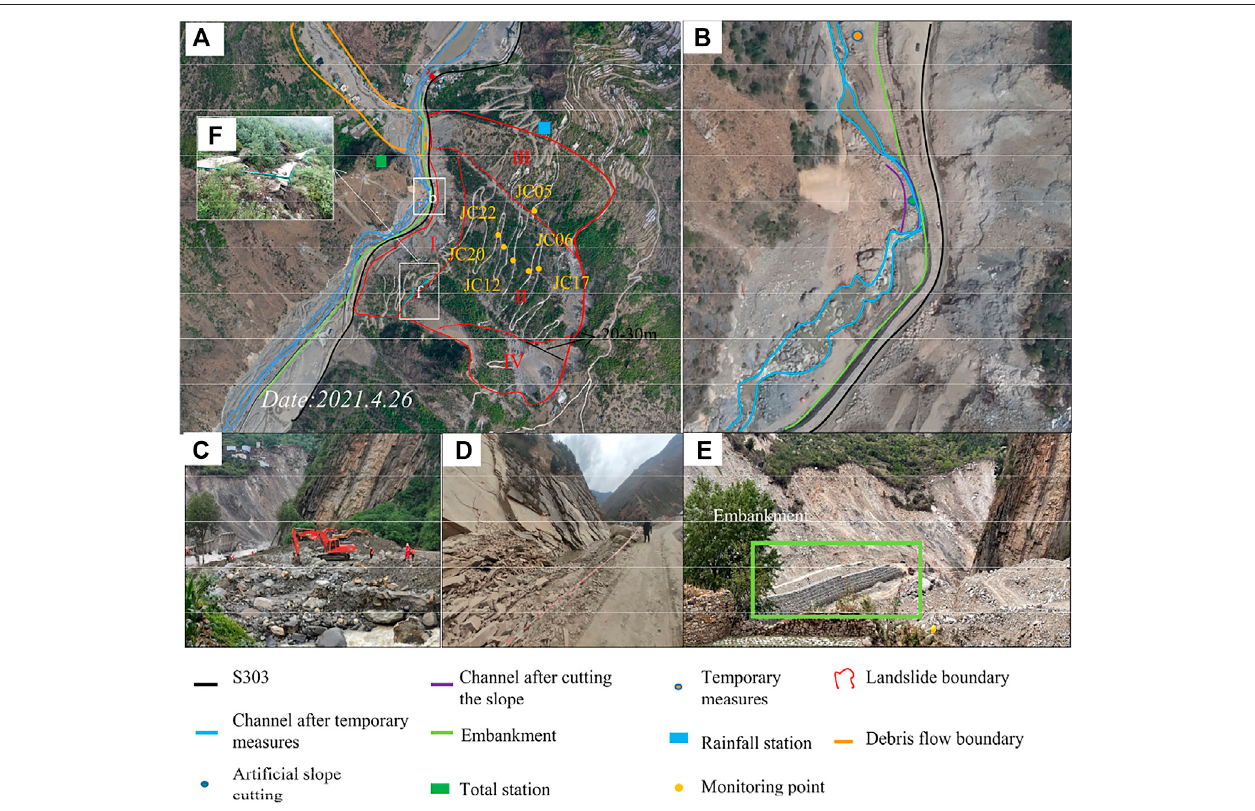
FIGURE 4 | Changes in the Meilong valley around the ANZ landslide and engineering measures after the debris- fl ow event. (A) Detailed characteristics of the reactivatedANZareaandemergencymonitoring scheme.(I:frontcollapsezone,II:maindeformationzone,III:upstream deformationzone,IV:downstream deformation zone). (B) In fl uence of engineering measures on channel evolution. (C) Temporary engineering measures: the excavator dredging the river. (D) Workers blasting the slope. (E) Temporary embankment. (F) Road falling